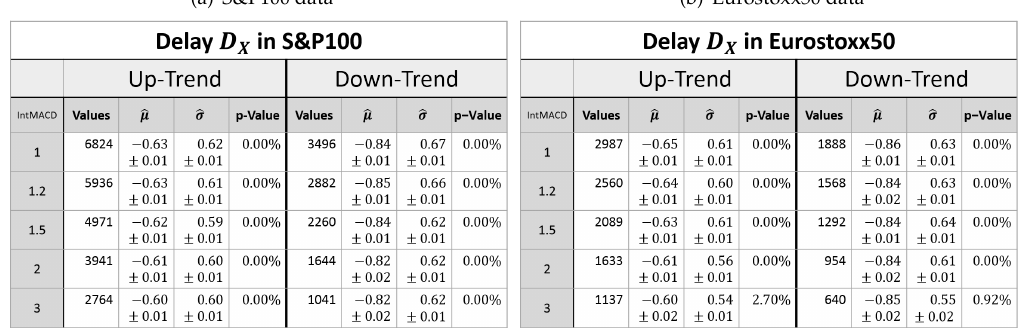
Figure 6. Measured and log-normal fit density of the delay in an up-trend with scaling one for S&P100 stocks. The data are visualized with a histogram from zero to five with a bin size of 0.11. Table 2. Parameters of the log-normal fit for the delay D X in up- and down-trends. ( a ) S&P100 data. ( b ) Eurostoxx50